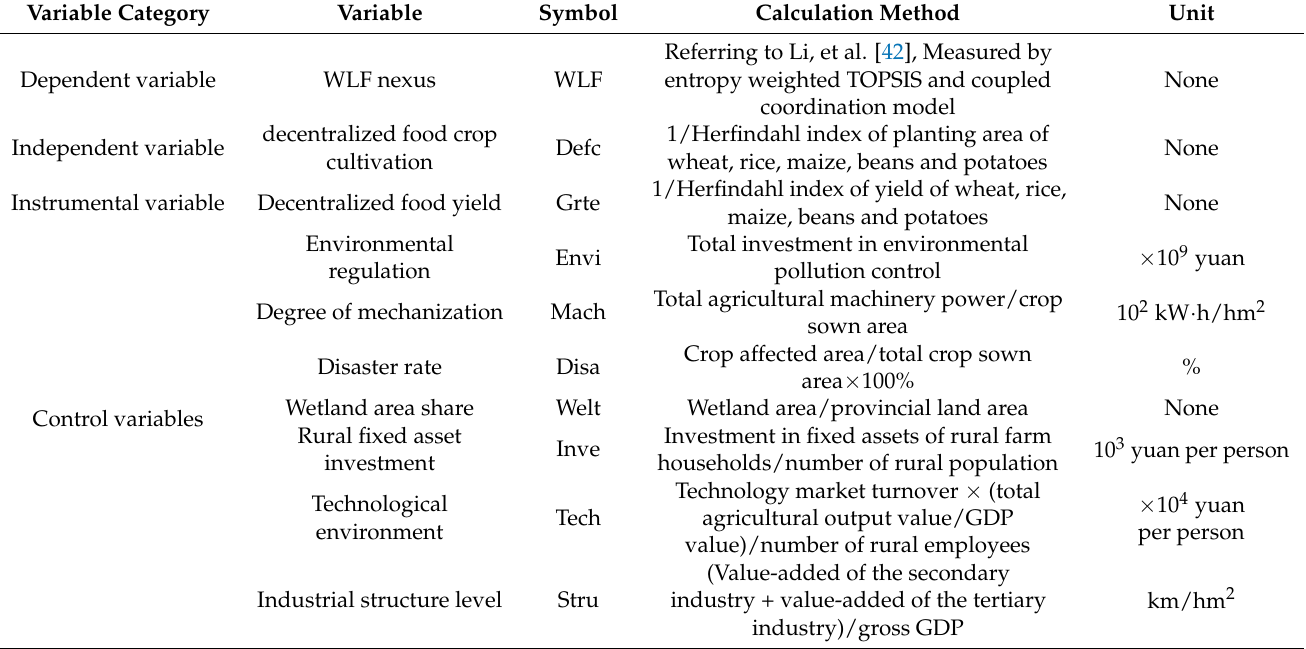
Table 1. Variables and calculation